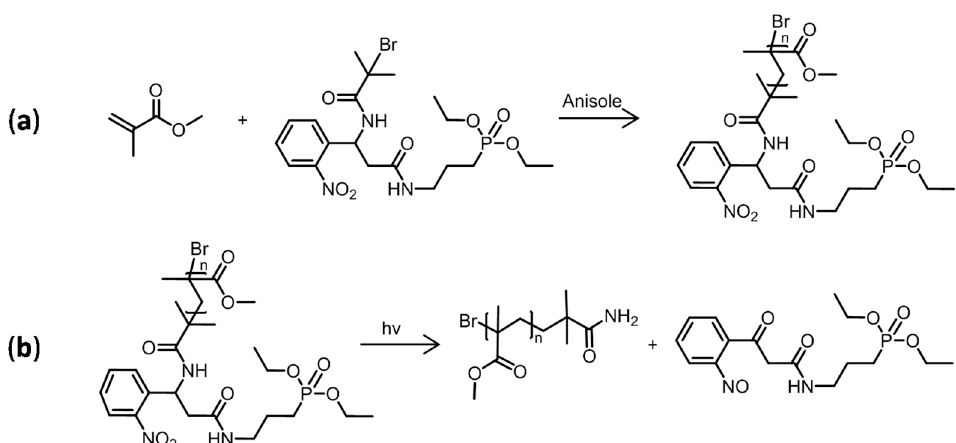
Figure 6. ( a ) Homopolymerization of MMA in solution using the photocleavable initiator; ( b ) prob- able products resulting from the photocleavage reaction of the grafted PMMA in solution